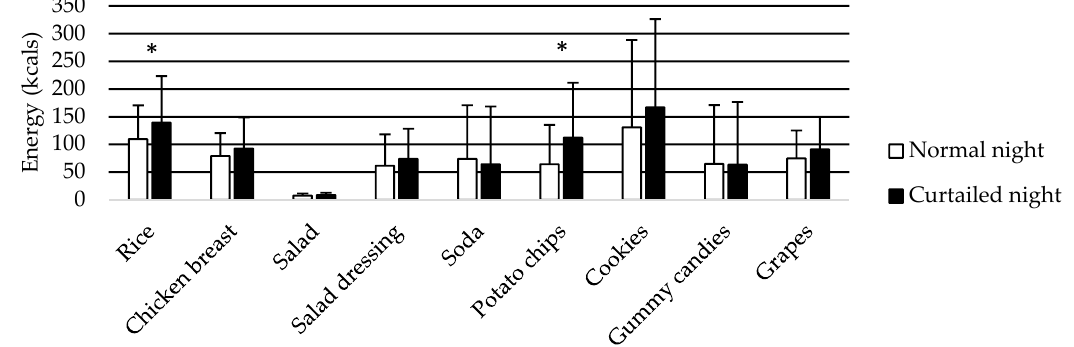
Figure 1. Means and standard deviations of selected portion sizes of meals and snacks after the normal night and curtailed night. The amount of energy selected from rice and potato chips was significantly higher after the curtailed night. * p < 0.05.